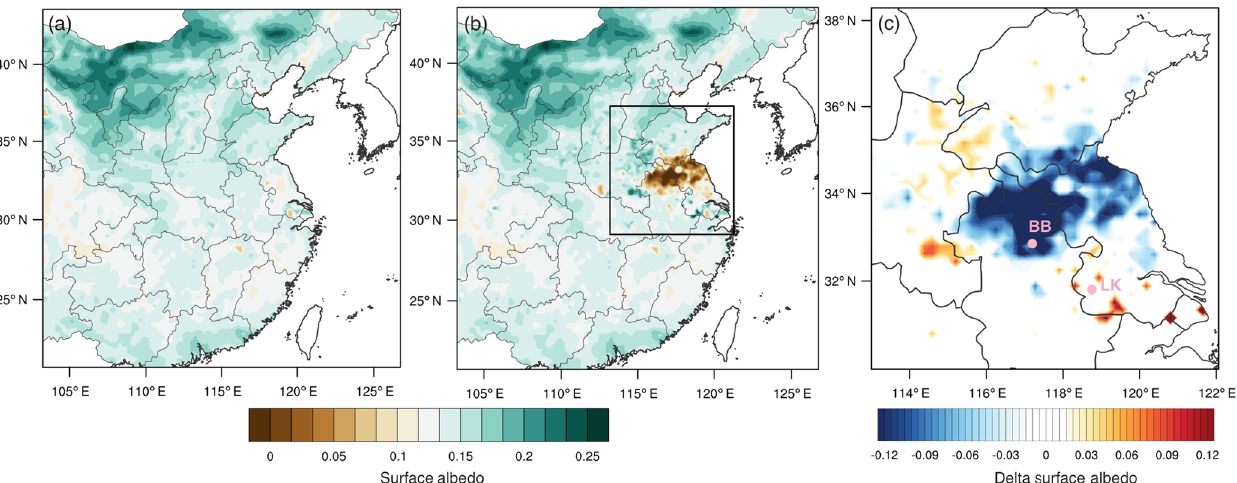
Figure 7. Surface albedo distribution in experiments (a) CTL and (b) ABD, and (c) difference between the parallel ones (ABD − CTL). Note that the region in panel (c) corresponds to the black box in panel (b) .